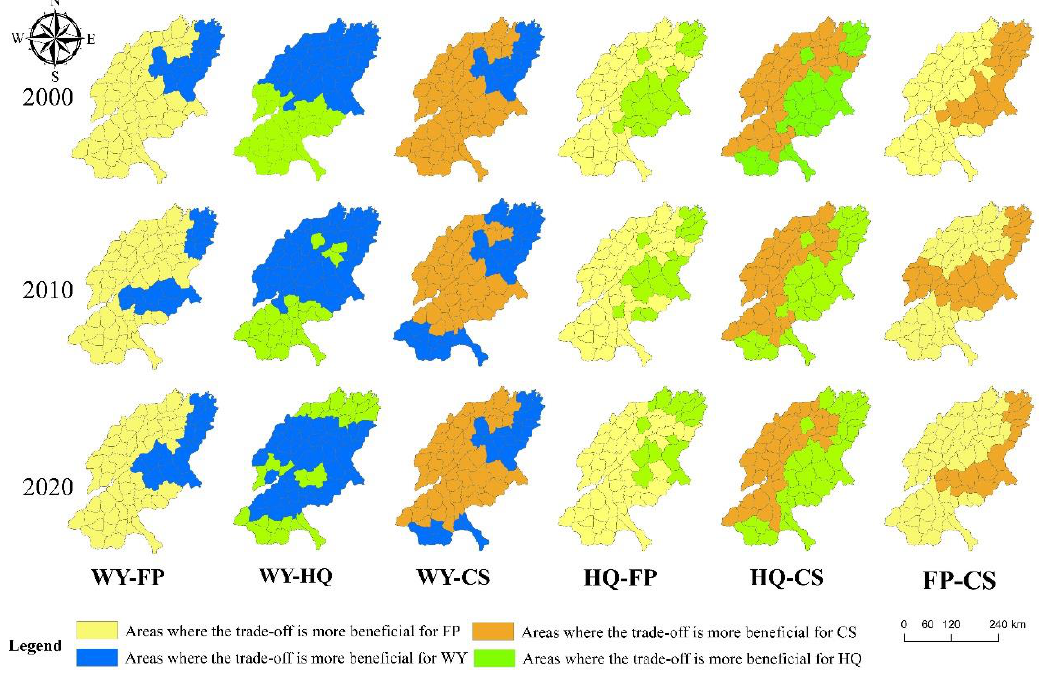
Figure 7. Relative benefits of ESs in the trade-off for different regions (see abbreviations in Figure